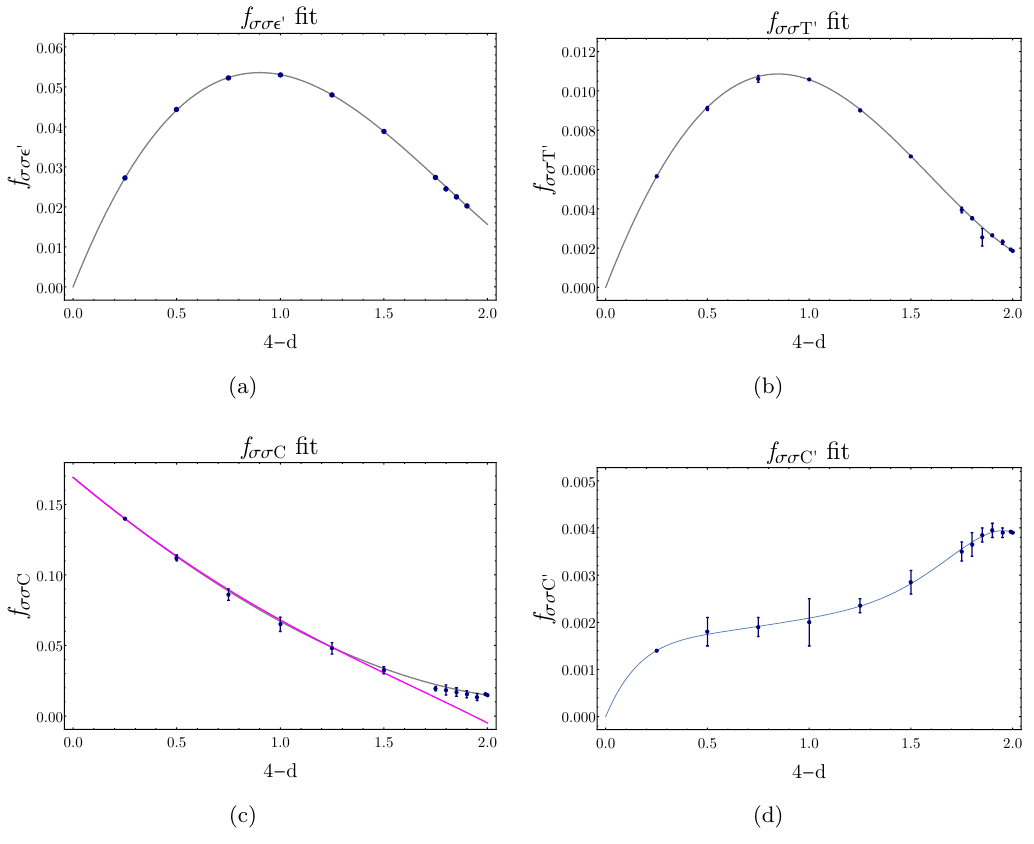
Figure 11 . Polynomial (cid:12)t of f (cid:27)(cid:27)(cid:15) 0 ; f (cid:27)(cid:27)T 0 ; f (cid:27)(cid:27)C ; f (cid:27)(cid:27)C 0 ; as functions of y = 4 (cid:0) d . Figure (c) includes the known epsilon expansion result [31,